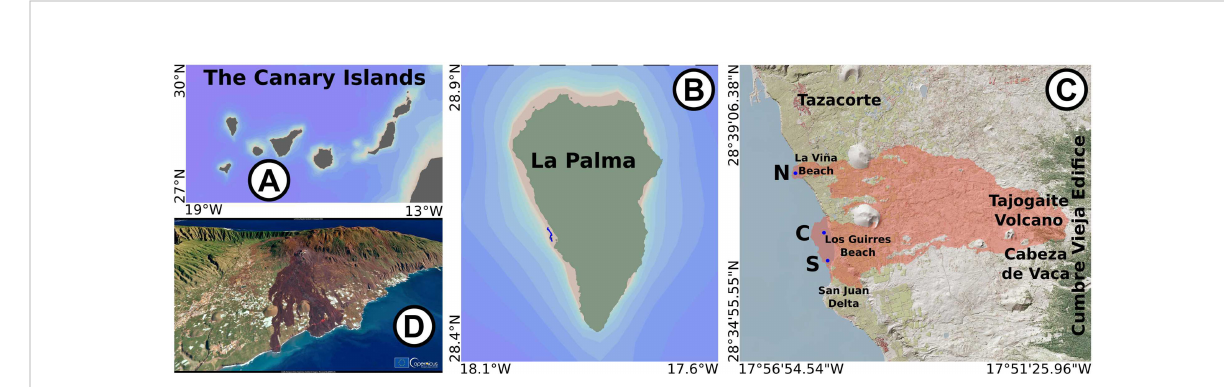
FIGURE 1 Map of the Canary Islands (A) , the volcanic island of La Palma (B) (Ocean Data View images, Schlitzer, 2021), with indication of (C) the inland area affected by the 2021 eruption and the two formed deltas (IGME et al., 2021). The southern delta was formed after lava arriving on September 28th and November 10th, while the northern delta was formed after November 22nd. North (N), center (C), and south (S) correspond with the locations of the pre-lava arrival stations. (D) 3D visualization of the new landscape (European Union, Copernicus Sentinel-2